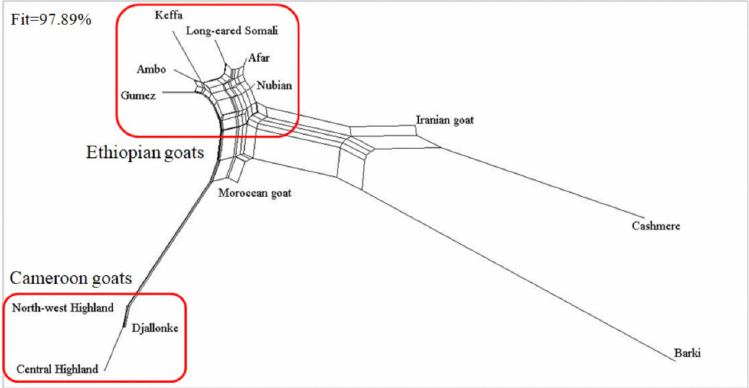
Fig 6. Neighbor-Net network analysis of the 13 goat populations analyzed, based on pair-wise (F ST ) genetic distances using 43421 autosomal single nucleotide polymorphisms